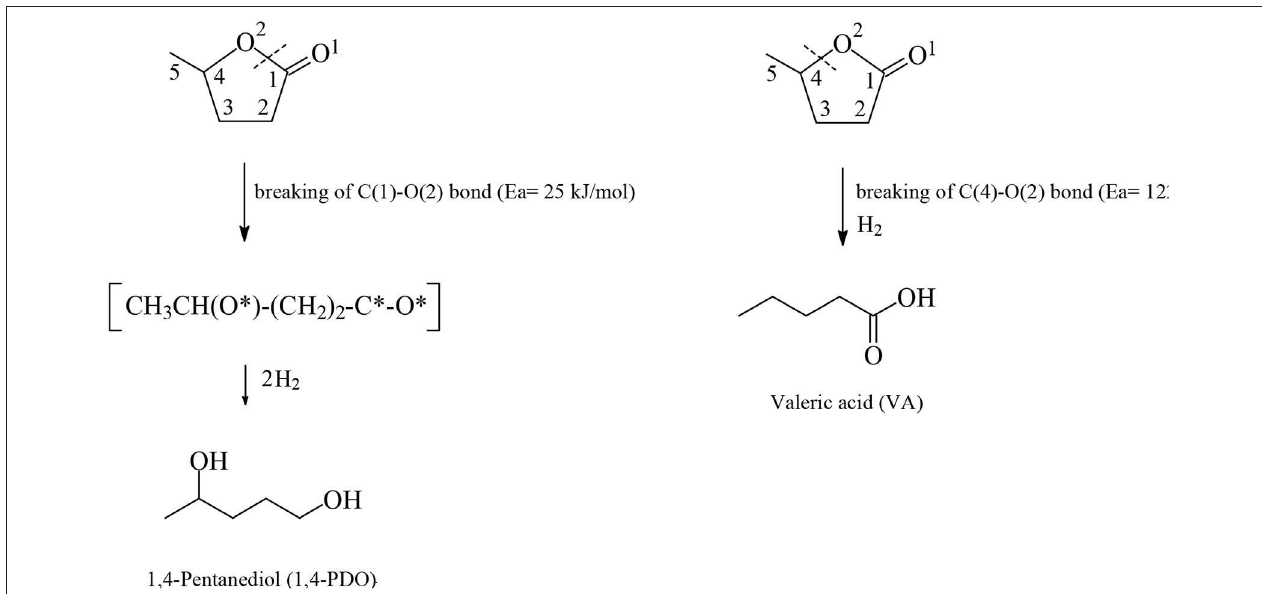
FIGURE 10 | Ring-opening pathways of GVL through breaking the C(1)-(O)2 bond which after hydrogenation eventually leads into 1,4-PDO and through C(4)-(O)2 bond breaking into VA.